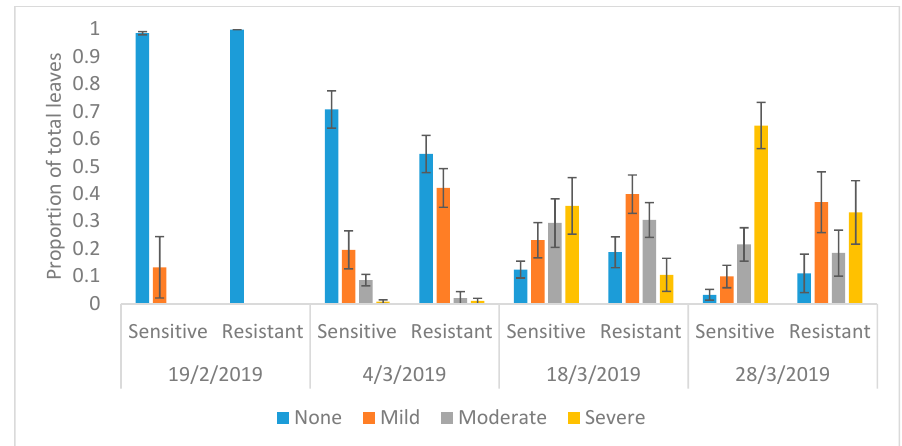
Figure A2. Setup of the 24 pots of Phaseolus vulgaris . The resistant and sensitive genotype pots are placed randomly.